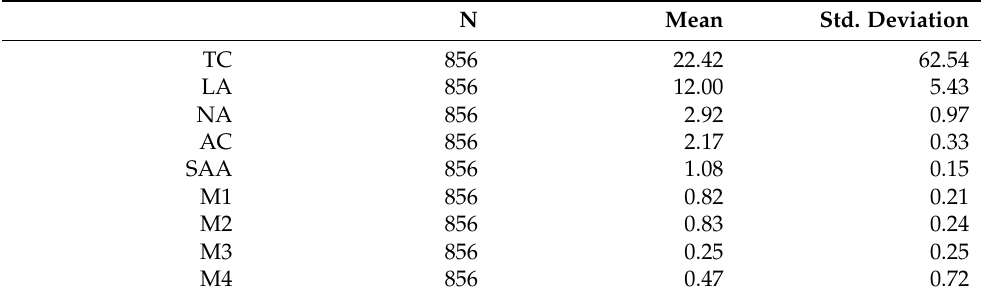
Table 8. Descriptive Statistics.